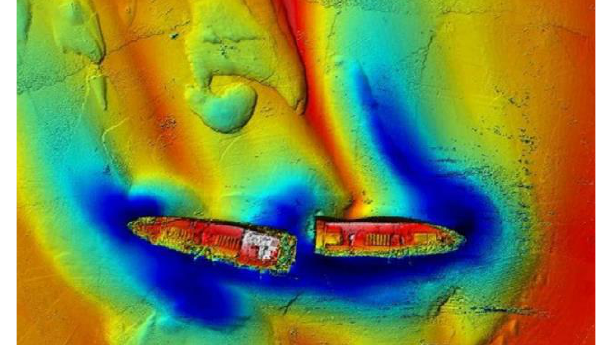
Figure. 12. Ship wreck recorded using side-scan and